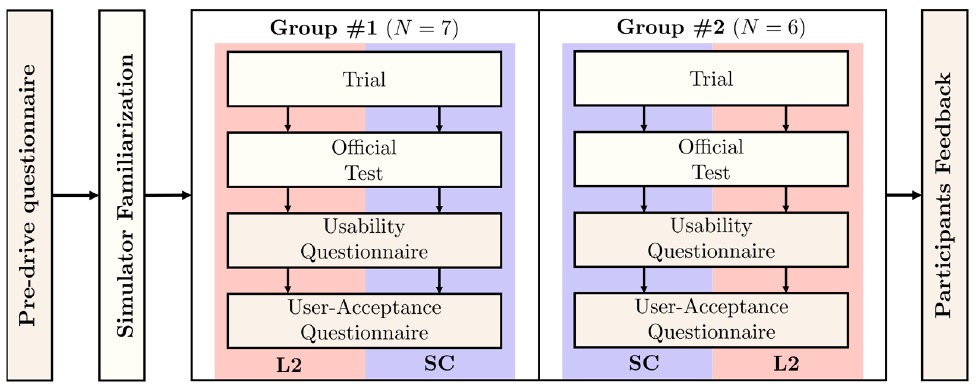
Figure 4. Outline of the within-subject driver study.